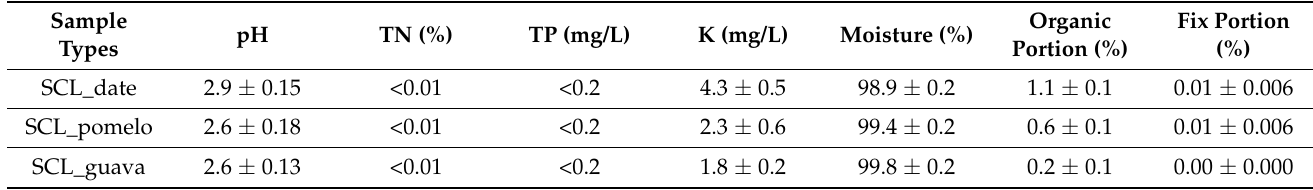
Table 1. Properties of three fruit-tree SCLs. Value = Mean ± Std. dev. (n =